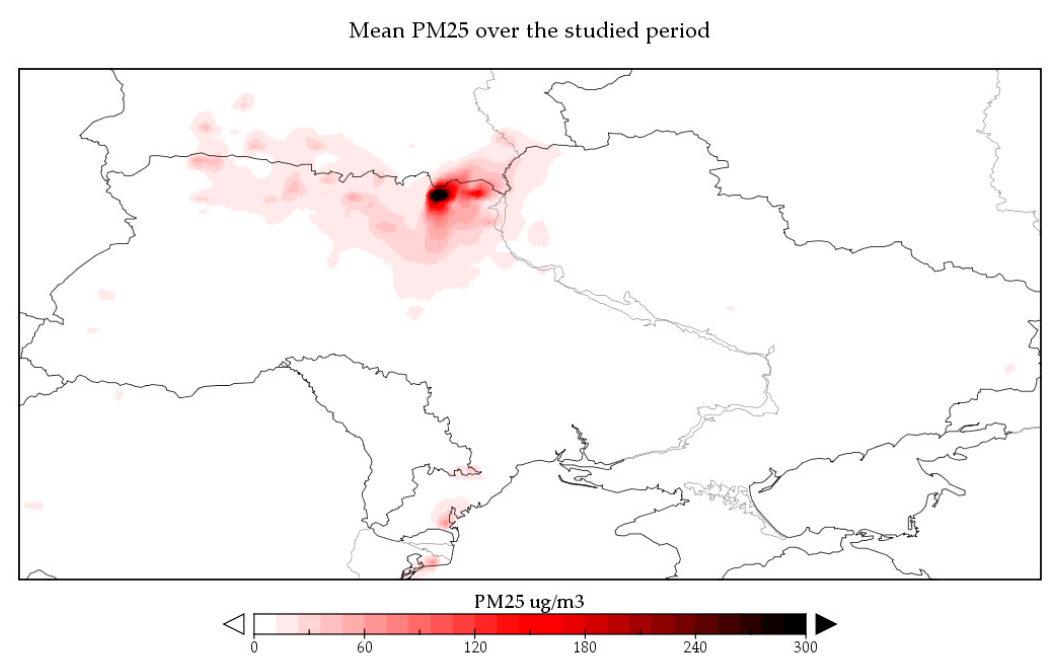
Figure 4. WRF-Chem mean PM 2.5 (ug/m 3 ) over the studied